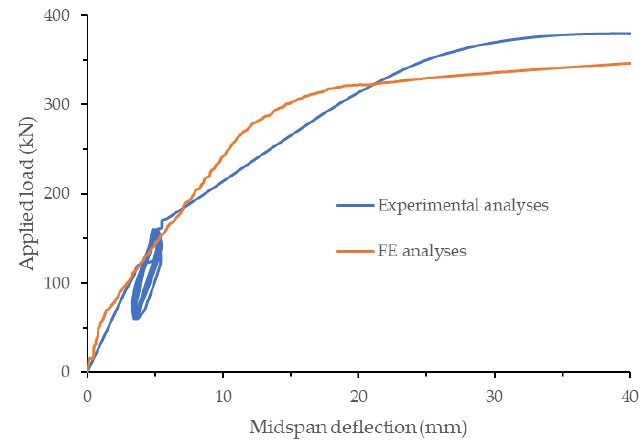
Figure 11. Load-displacement curve for a UHPC layer ratio of 0.3.